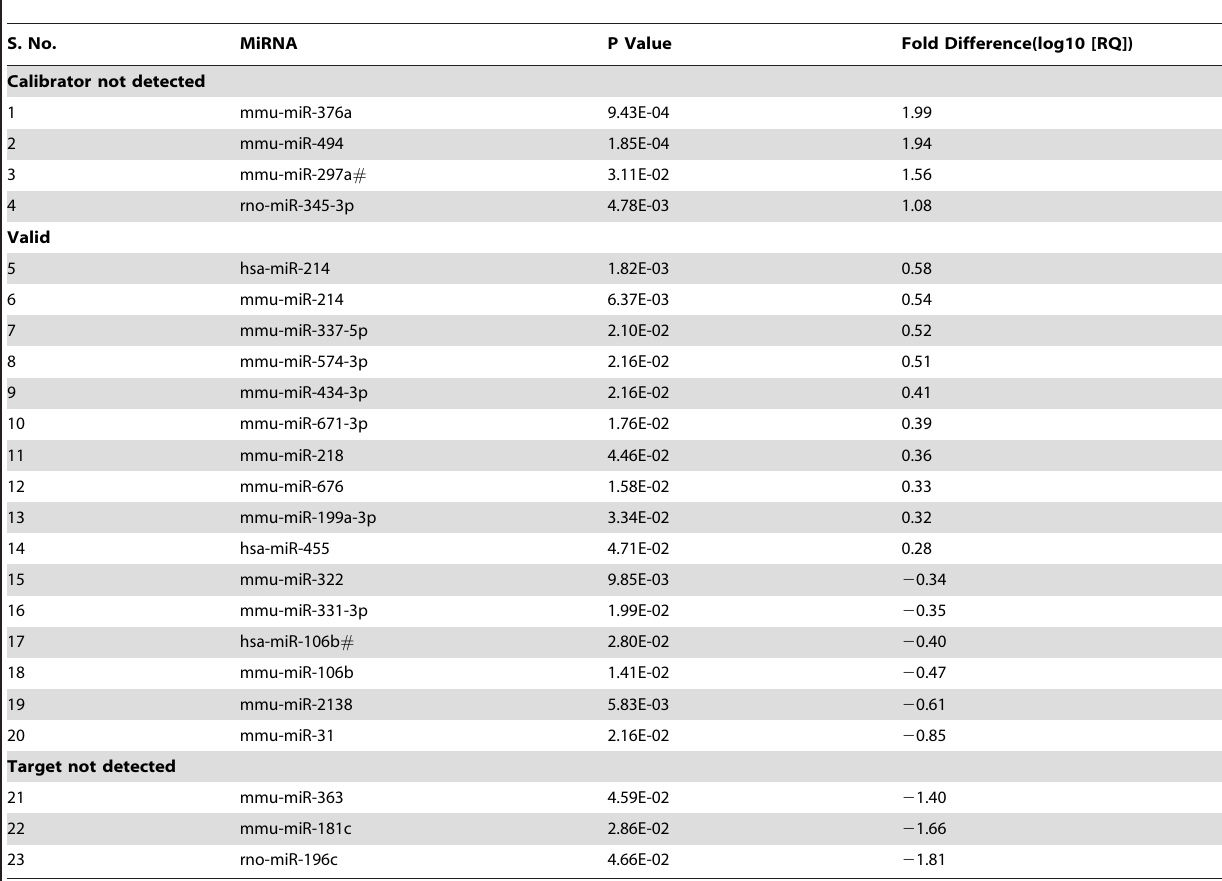
Table 1. Significantly modulated miRNA in